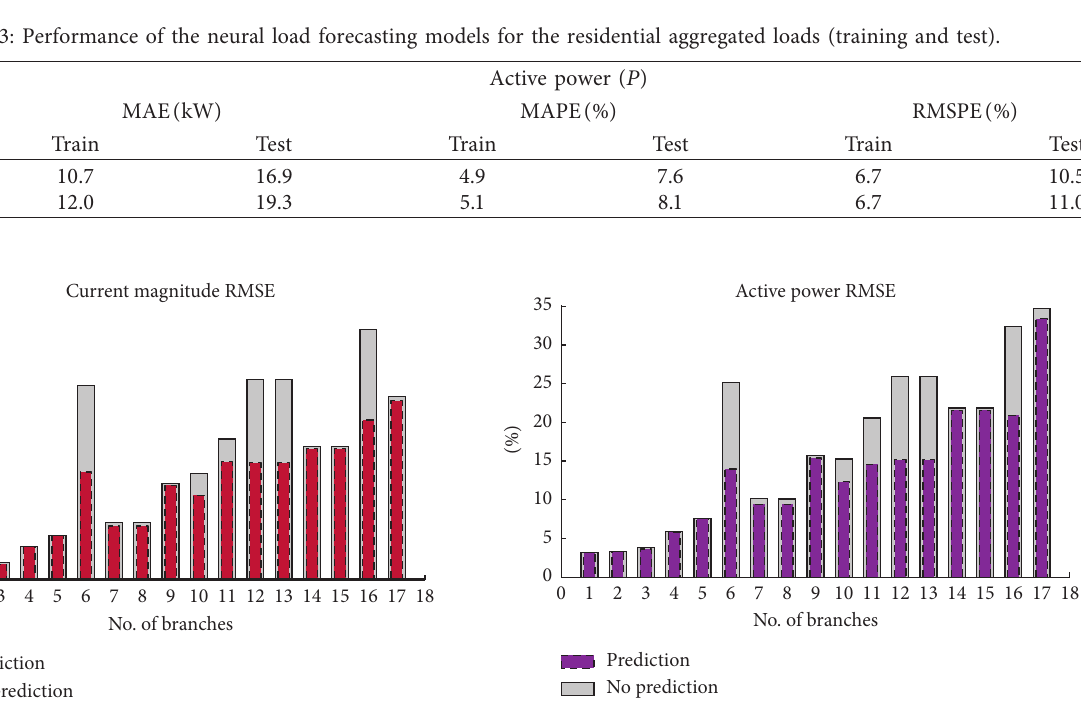
Figure 11: Current magnitude RMSEs obtained with and without the ANN-based prediction.